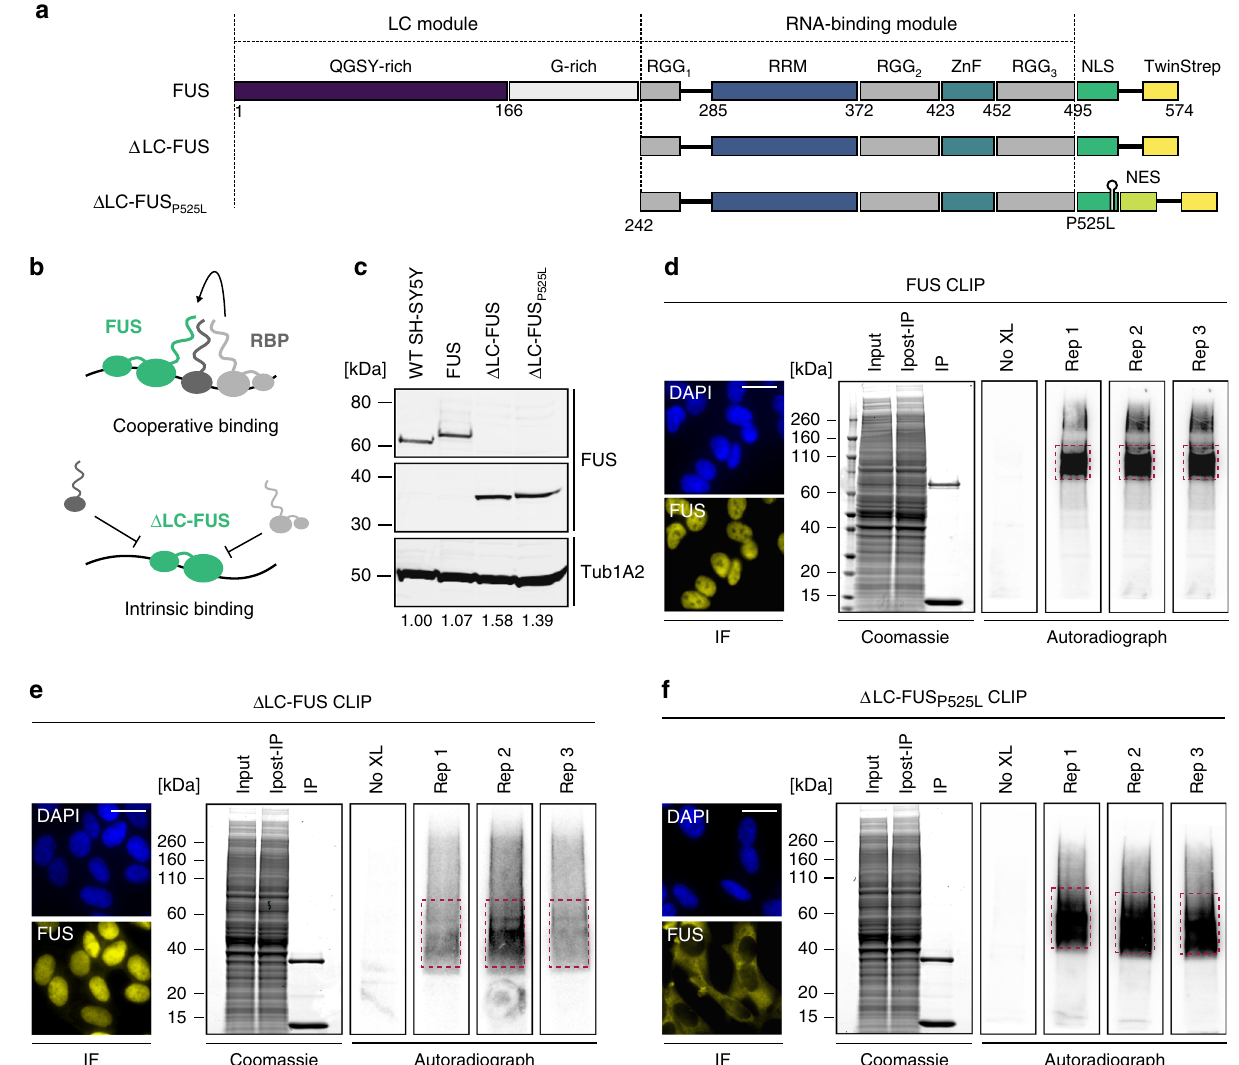
Fig. 1 An RBD-centric FUS CLIP approach. a Schematic representation of the Twin-Strep-tagged FUS constructs used for CLIP. b In addition to binding as a free molecule, FUS may be recruited to RNA via interactions with other RBPs. This may confer foreign speci fi city to FUS and promote binding to low-af fi nity binding sites. c Western blot showing expression of FUS CLIP constructs in comparison to endogenous FUS in the parental SH-SY5Y cell line, detected using anti-FUS antibodies. Tub1A2 served as a loading control. Relative FUS expression levels were determined by densitometry. n = 3. d – f Immuno fl uorescence con fi rmed the expected nuclear or cytoplasmic localisation of FUS CLIP constructs, visualised using anti-FUS antibodies. Nuclei were counterstained with DAPI. Scale bar = 10 µ m, n = 1. Protein – RNA complexes were puri fi ed using Strep-Tactin beads, separated by SDS-PAGE and their purity was assessed by Coomassie staining. Autoradiographs of three biological replicates reveal characteristic shifts above the free protein. RNA was isolated from the regions of the membranes indicated by red dashed